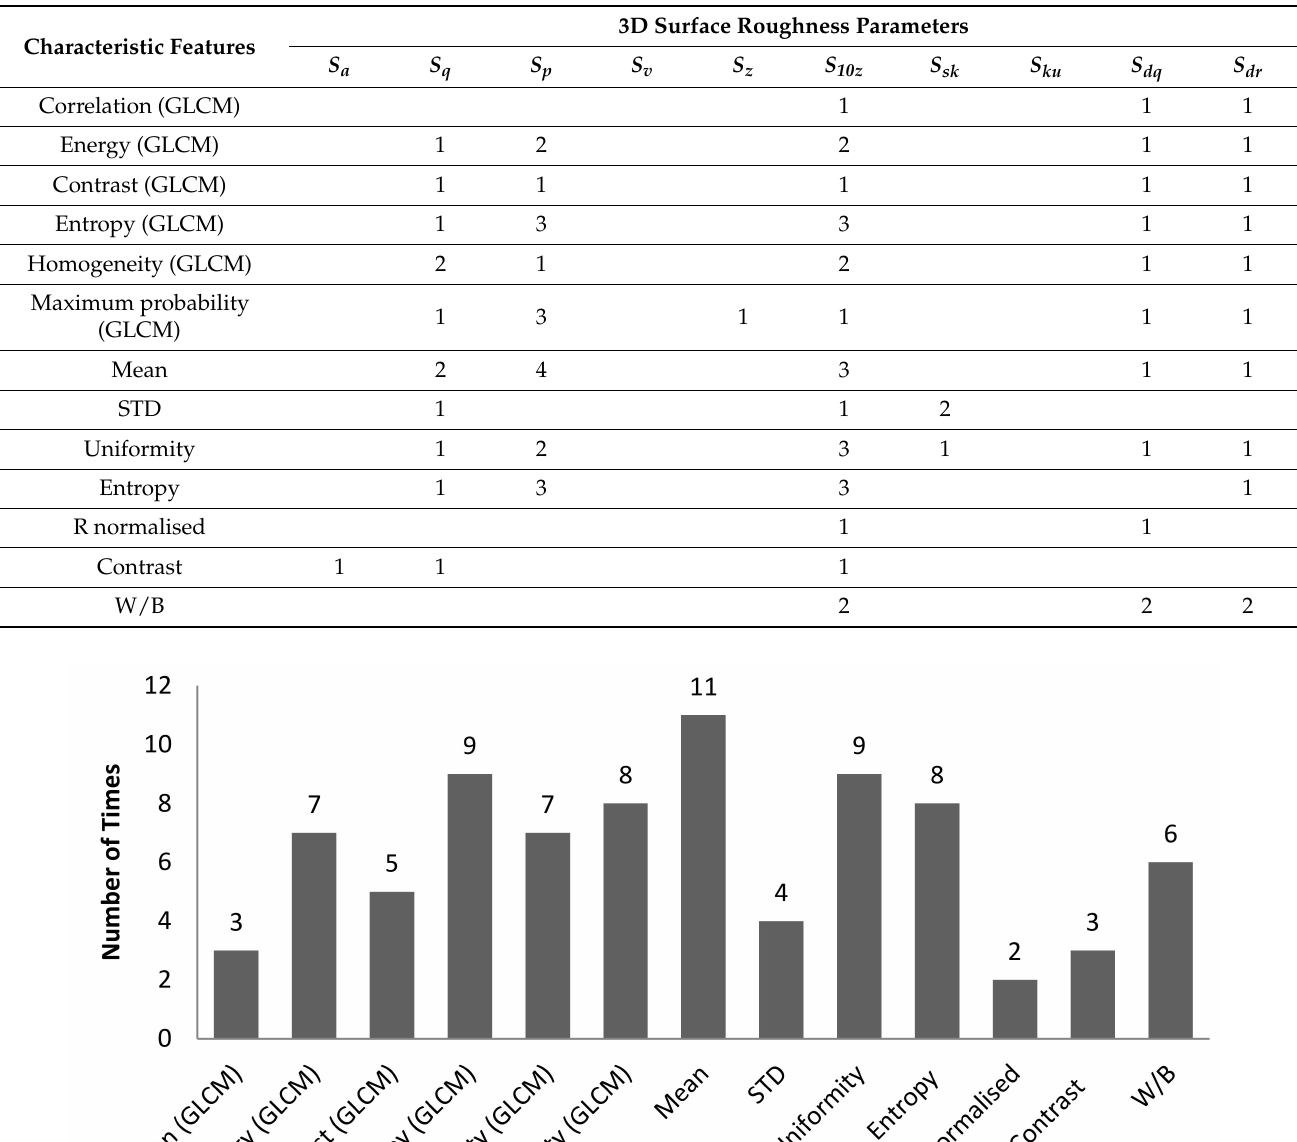
Table 4. Tabulation of number of times a correlation between characteristic features and 3D surface roughness occurs with R 2 ≥ 0.7 for an illumination angle of 60 ◦ for experimental setup 1.